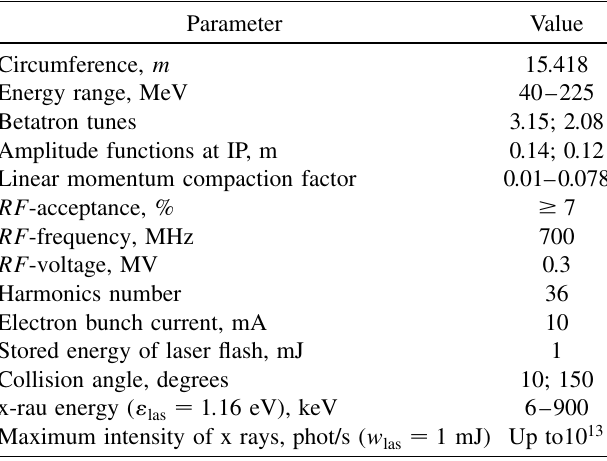
TABLE I. Main parameters of the storage ring and parameters of electron and Compton